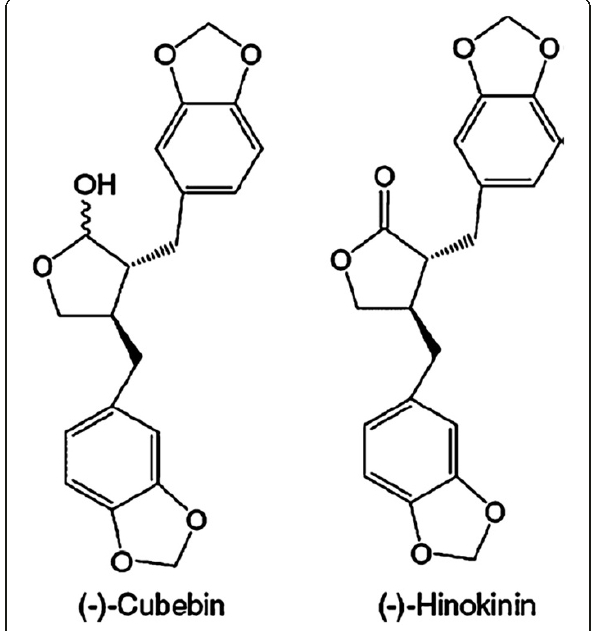
Figure 1 Chemical structures of ( − )-cubebin and ( −